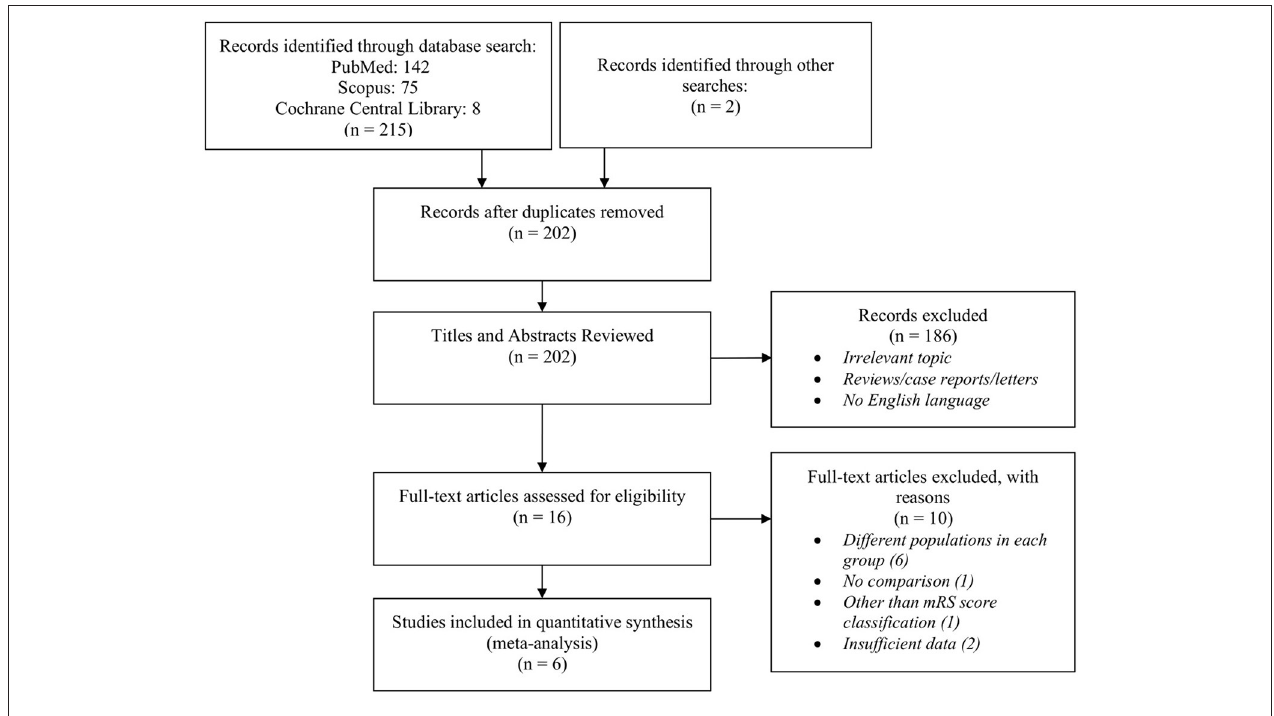
FIGURE 1 | Flowchart of study selection algorithm according to PRISMA guidelines.